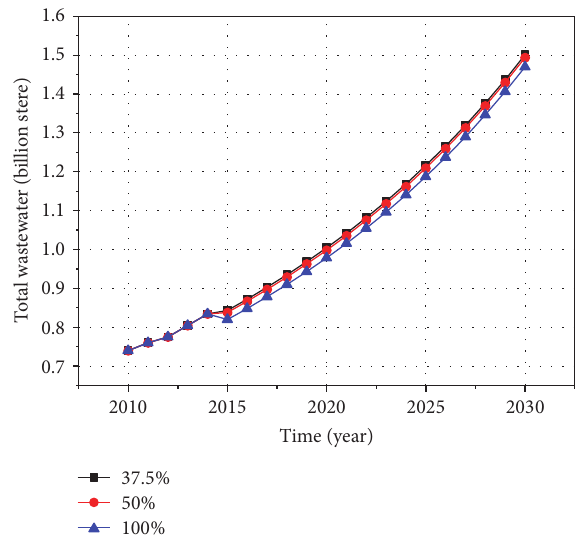
Figure 8: Total wastewater under different per ten thousand yuan GDP water consumption .